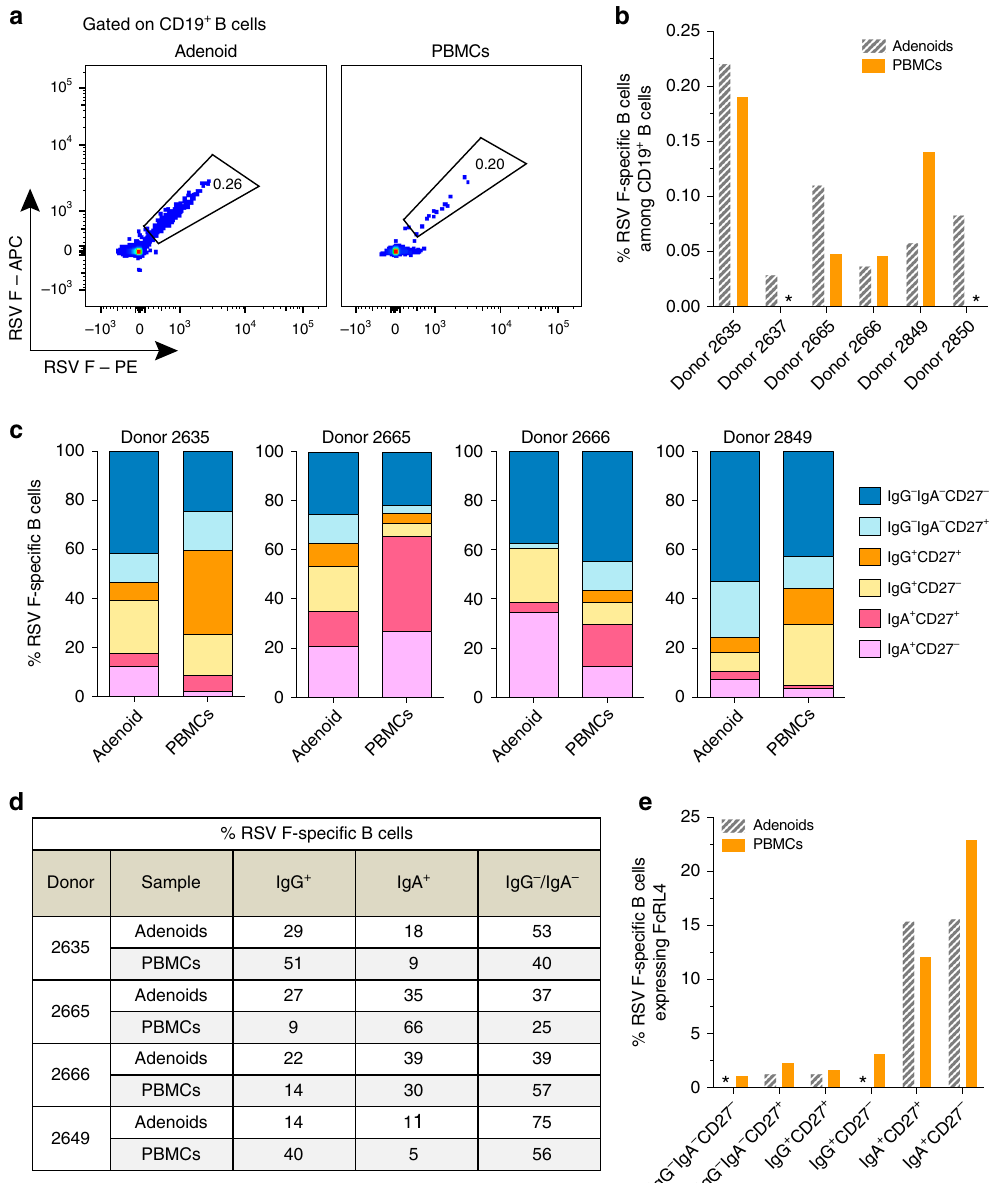
Fig. 1 RSV F-speci fi c B cell responses in the adenoids and peripheral blood of young children. Shown is the frequency of RSV F-speci fi c B cells among CD19 + B cells in adenoid (left) and PBMCs (right) for a representative donor ( a ) and a summary for all 6 donors analyzed ( b ). The frequency of RSV F-reactive B cells within the CD14 — CD3 — CD8 — CD19 + population is shown inside the gate. Asterisks in b indicate B cell responses that were below the limit of detection. c Index sort analysis of surface markers expressed on B cells from which RSV F-reactive antibodies were isolated. d Isotype distribution of RSV F-speci fi c B cells in adenoid and PBMCs. e Percentage of RSV F-reactive, FcRL4 + B cells within each memory B cell subset described in